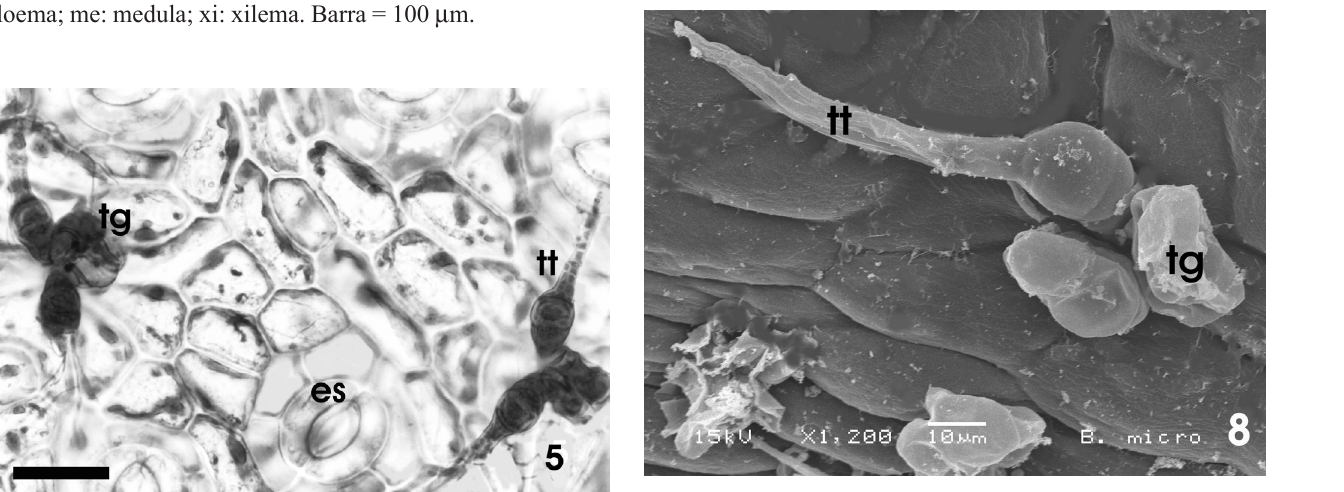
FIGURA 8 – B. microcephala – Vista frontal da epiderme do